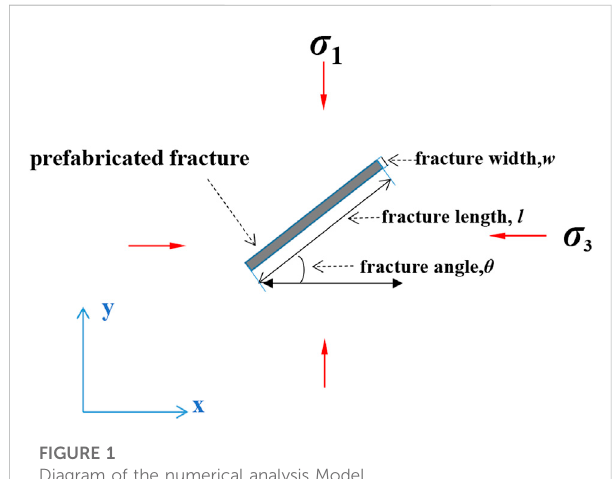
Diagram of the numerical analysis Model.